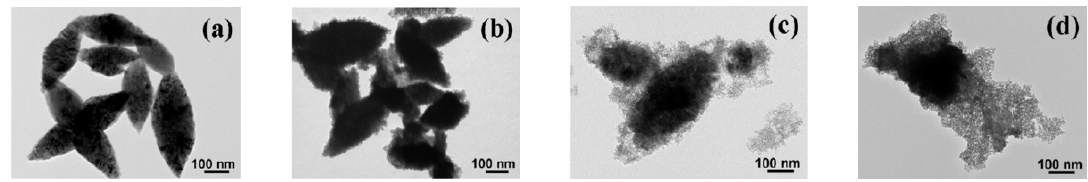
Figure 3. TEM images of the sample synthesized with different mole ratios of ZnO to FeCl 3 : ( a ) 1:0, ( b ) 6:1, ( c ) 3:1 and ( d ) 1:1 [18].